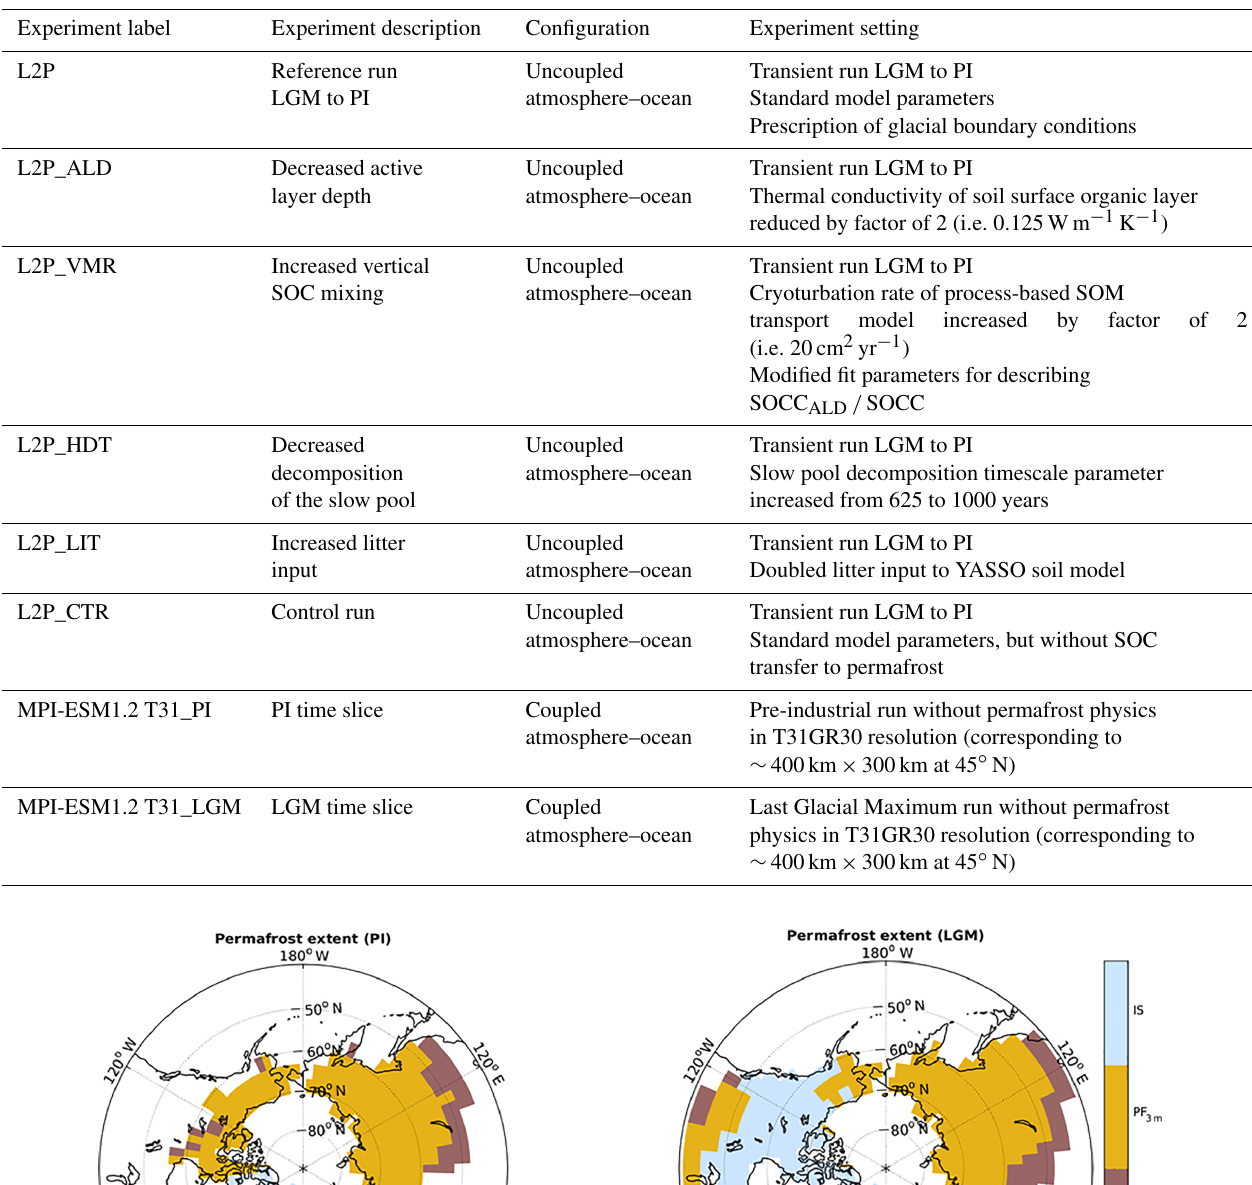
Table 1. Performed transient and time-slice model experiments with MPI-ESM. Experiment label